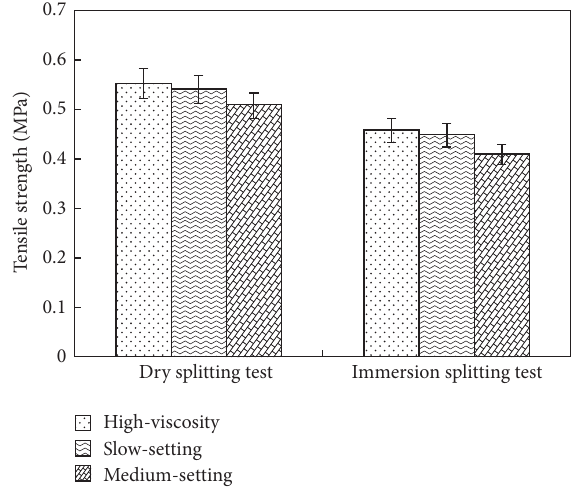
Figure 8: Final tensile strength for cold recycled asphalt mixtures with different types of emulsified asphalt.